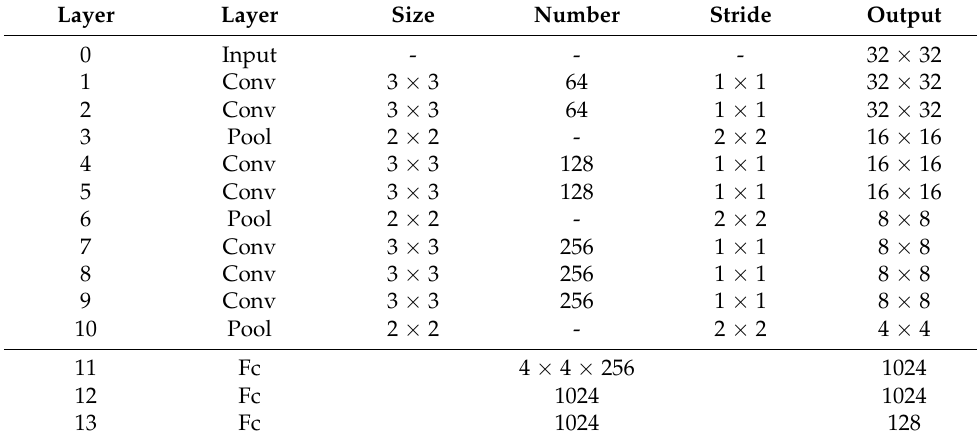
Table 1. Network parameters of the